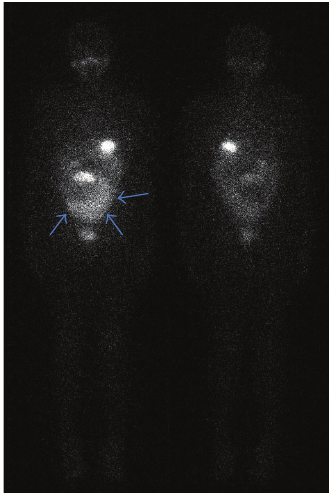
Figure 1: A 24-year-old female patient who had undergone total thyroidectomy with central and bilateral neck dissection for papillary thyroid cancer treated with radioiodine after. Anterior and posterior whole-body planar imaging (left and right) obtained 72 hours after oral administration of a diagnostic dose of 740 MBq of 131 I. They show a large rounded focus of activity in the lower abdomen and pelvis. There is no abnormal radioiodine uptake in the neck areas.